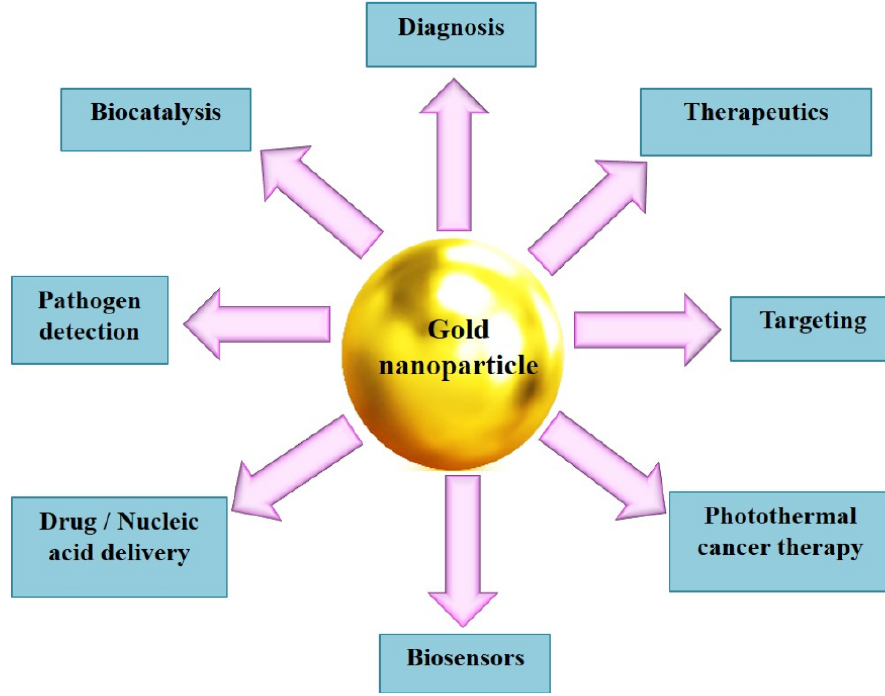
Figure 1. Multifunctional applications of gold